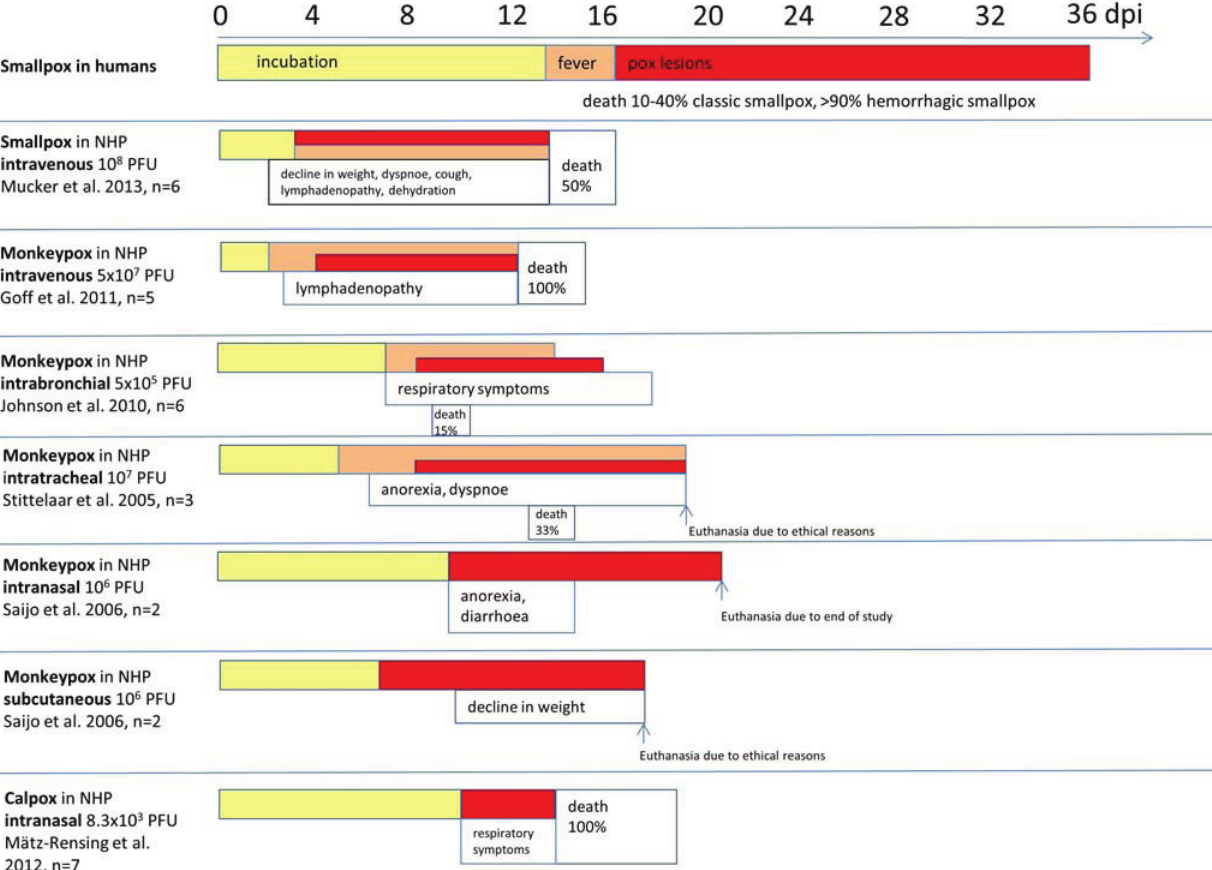
Figure 5. Comparison of disease courses in different orthopoxvirus models.